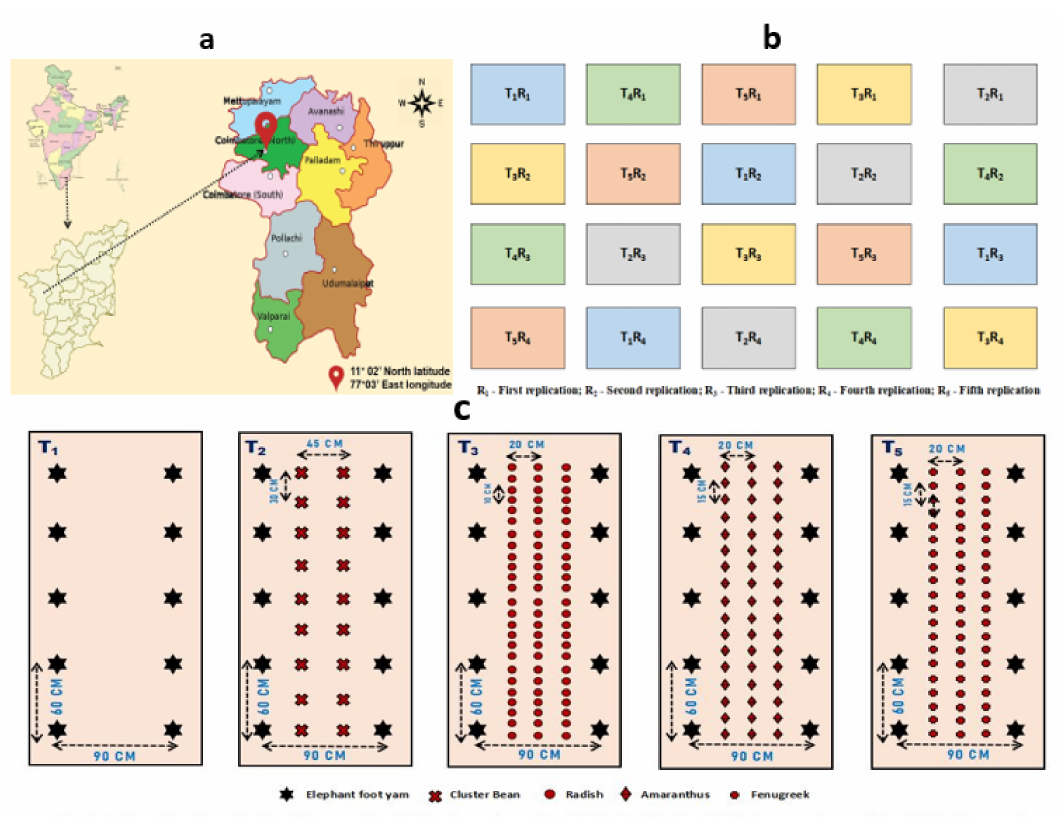
Figure 1. ( a ) Schematic map of the research area; ( b ) experimental field layout; ( c ) details on row arrangements of treatments studied.